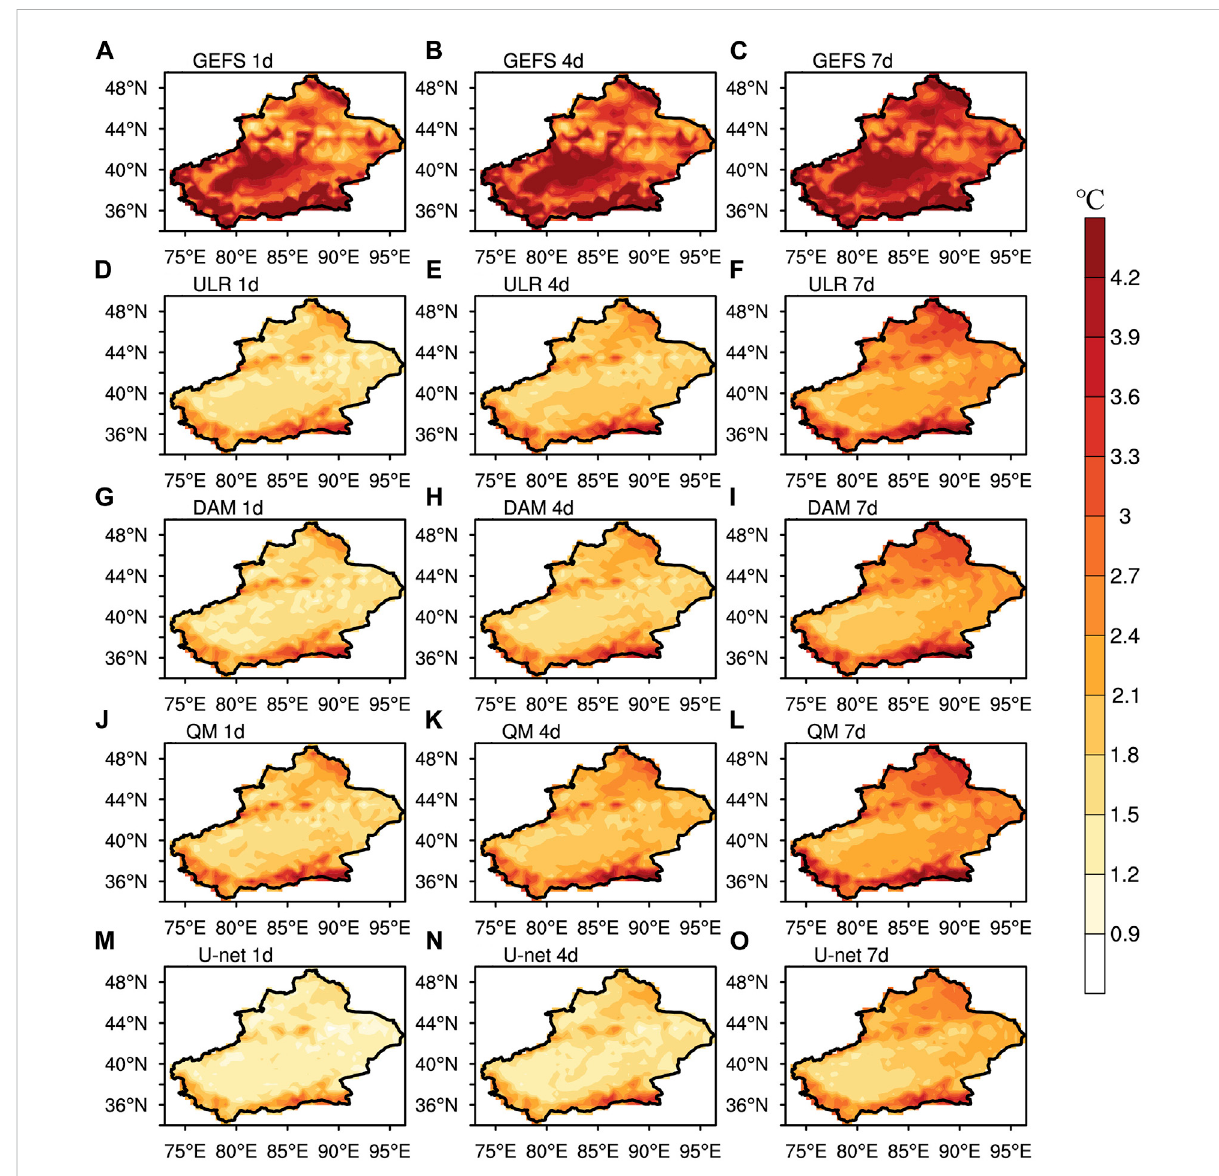
FIGURE 4 SpatialdistributionsoftheMAE( ° C)forsurfaceairtemperatureforecastswithleadtimesof1,4,and7daysderivedfromGEFS (A – C) ,ULR (D – F) , DAM (G – I) , QM (J – L) and U-net (M – O)